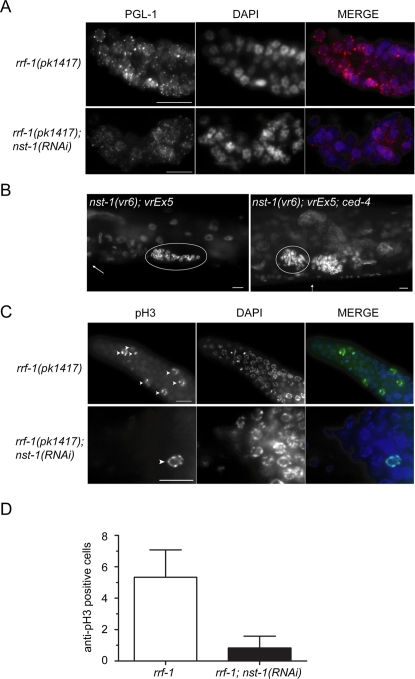
Germ cells lacking nst-1 fail to proliferate.A. α-PGL-1 (red) and DAPI (blue) staining in dissected gonads of rrf-1(pk1417) controls and rrf-1(pk1417); nst-1(RNAi) progeny. Similar staining was seen in nst-1(vr6); vrEx5 animals (not shown). B. nst-1(vr6); vrEx5 and nst-1(vr6); vrEx5; ced-4(n1162)dpy17(e164) soma-rescued transgenic animals were stained with DAPI to visualize nuclei. Arrows indicate the vulva. Germ cells from one gonad arm are circled. C. α-pH3 (green) and DAPI (blue) staining in dissected gonads of rrf-1(pk1417) controls and rrf-1(pk1417);nst-1(RNAi) progeny. Arrowheads mark the α-pH3-positive cells in each genotype. D. Quantification of α-pH3-positive cells. Error bars indicate standard deviation (n = 6 per genotype). Scale bars are 10 µm.